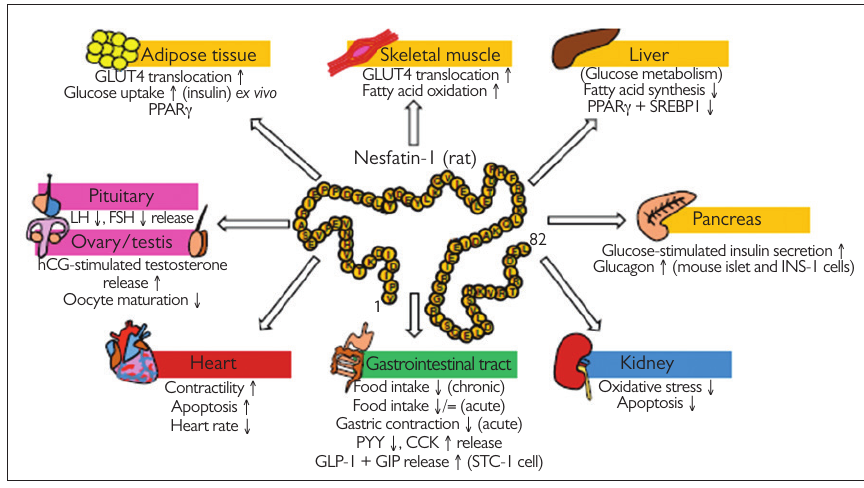
Figure 2. Nesfatin-1 and its effects. CCK: cholecystokinin; FSH: follicle stimulating hormone; GLP-1: glucagon-like peptide 1; GLUT4: glucose transporter 4; hCG: human choriogonadotropin; LH: luteinizing hormone; PPAR γ : peroxisome proliferator–activated receptor gamma; PYY: peptide YY; SREBP1: sterol-regulatory element-binding